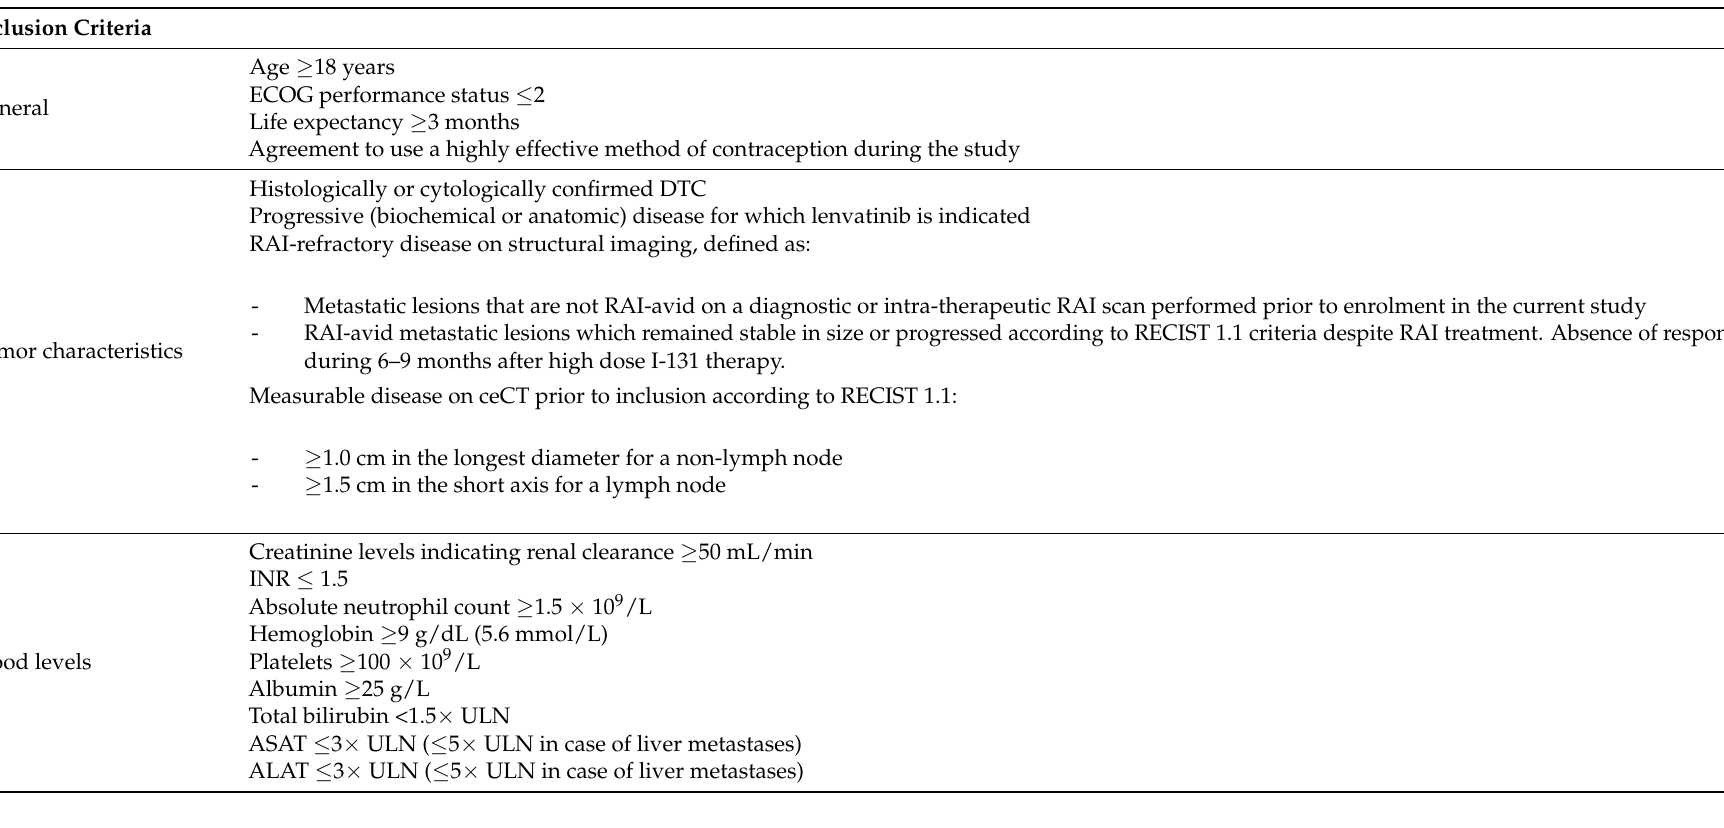
Table 2. Inclusion- and exclusion criteria of the RESET